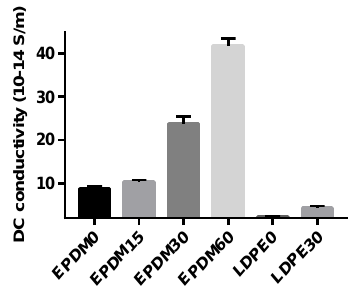
Figure 4. DC conductivity time of different fluorinated samples under 20 kV/mm.